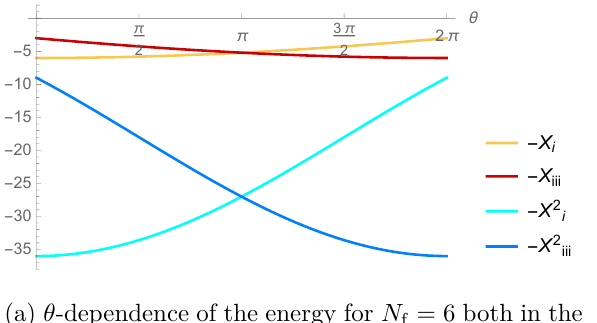
normal and superfluid phase. Figure 6 . θ -dependence of the energy and of the critical chemical potential for N f = 6